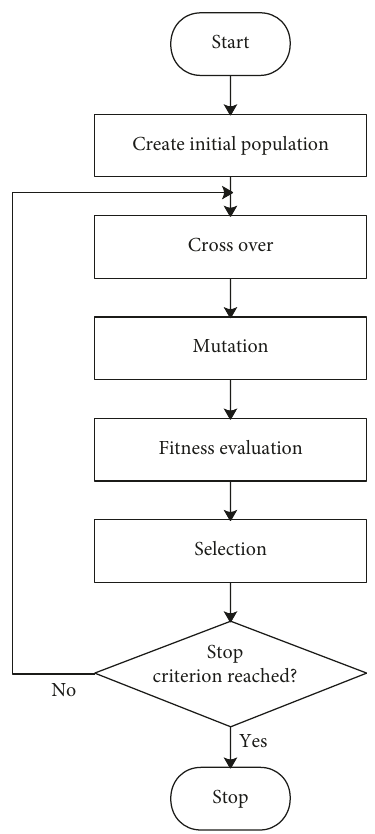
Figure 3: Block diagram of the genetic algorithm process.